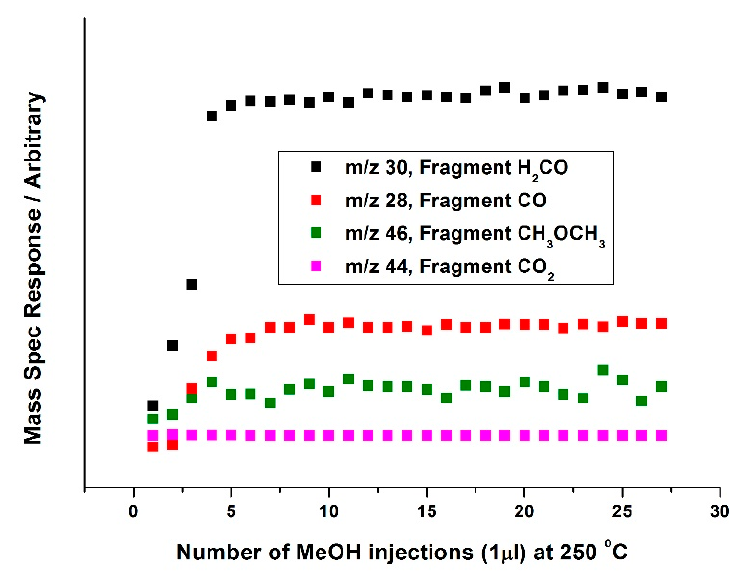
Figure 17. Online mass spectrometry data for experiment of Figure 16. Image adapted from C. Brookes et al., Catal. Sci. Technol. , 2016 , 6, 722